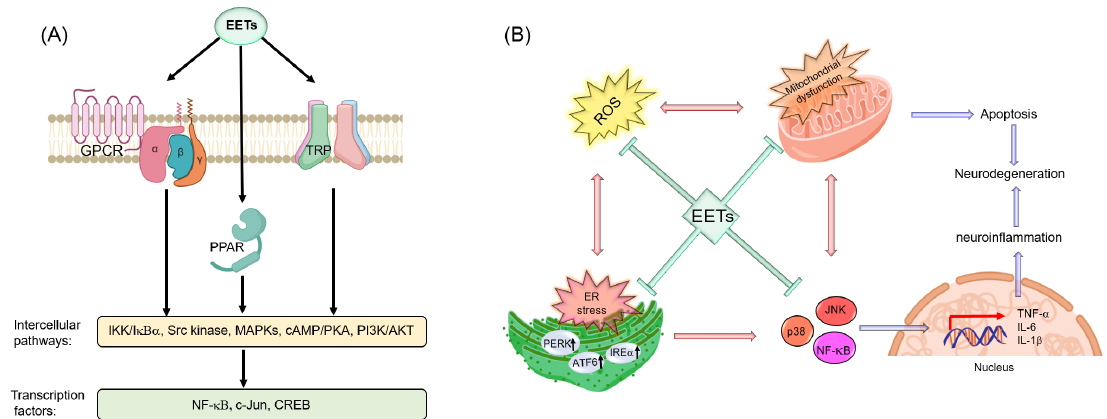
Figure 6. ( A ) Mechanisms of action of EETs through three main cellular targets. Verity of EET functions occur through PPAR-, TRP-, and GPCR-dependent mechanism, which activates intercellular pathways that modulate transcription factors in the target cell; ( B ) The possible anti-inflammatory mechanism of EETs. Abbreviations- ATF6: activating transcription factor 6, EETs: epoxyeicosatrienoic acids, ER: endoplasmic reticulum, GPCR: G protein-coupled receptor, IRE1 α : inositol-requiring enzyme alpha, PERK: protein kinase R-like endoplasmic reticulum kinase, PPAR: peroxisome proliferator-activated receptor, TRP: transient receptor potential channel, ROS: reactive oxygen species. Figure is in some parts created with biorender.com.